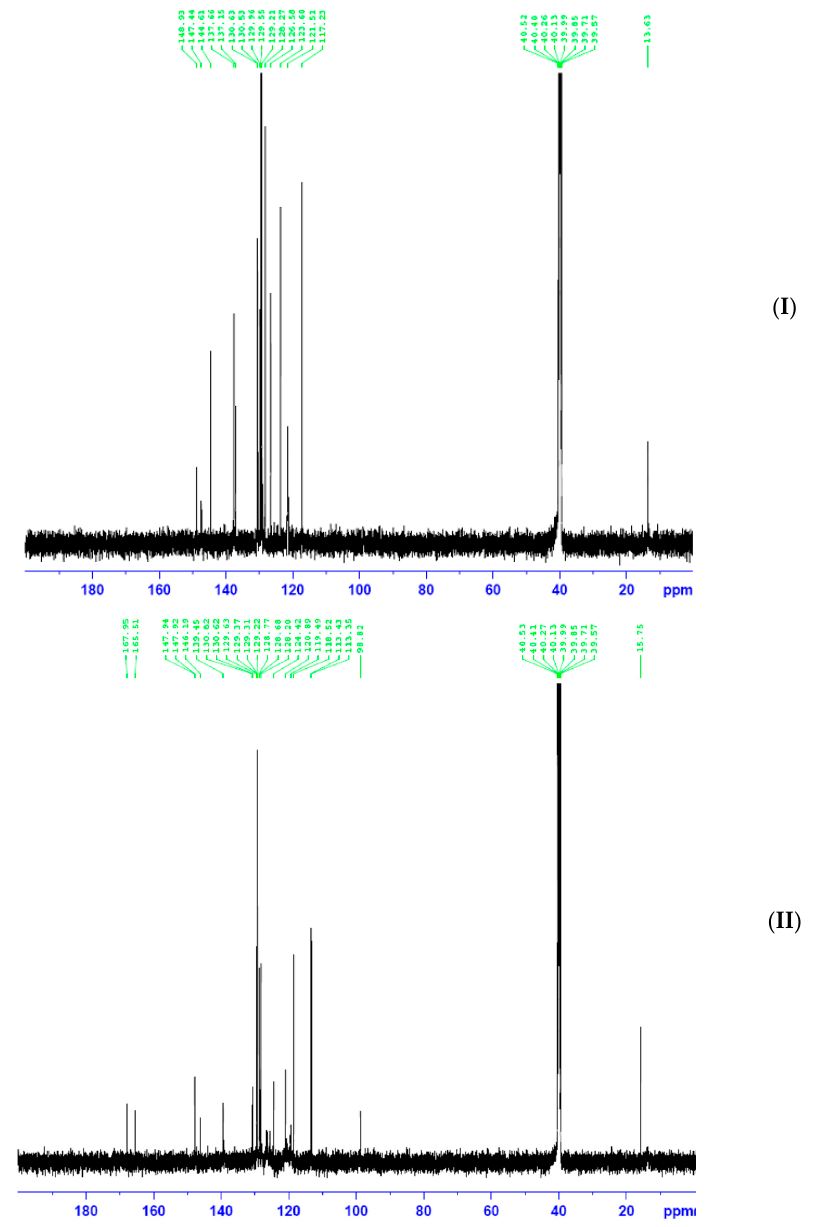
Figure 6. ( I ) 13 C NMR spectrum of Bmpp-Dh; and ( II ) 13 C NMR spectrum of Bmpp-Ph.